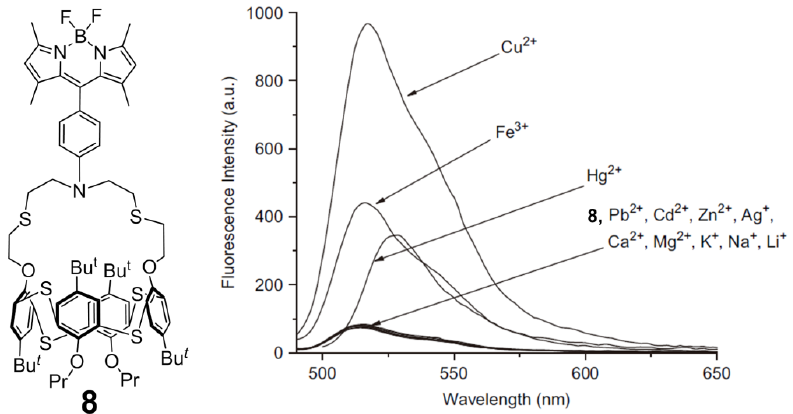
Figure 7. Chemical structure of thiacalix[4](N-phenylazacrown-5)ether 8 for selective recognition of Cu 2+ in acetonitrile solution (Cu 2+ : 4.0 equivalent, other metal cations: 40 equivalent). Reproduced with permission from Reference [71]. Copyright 2007 Elsevier.